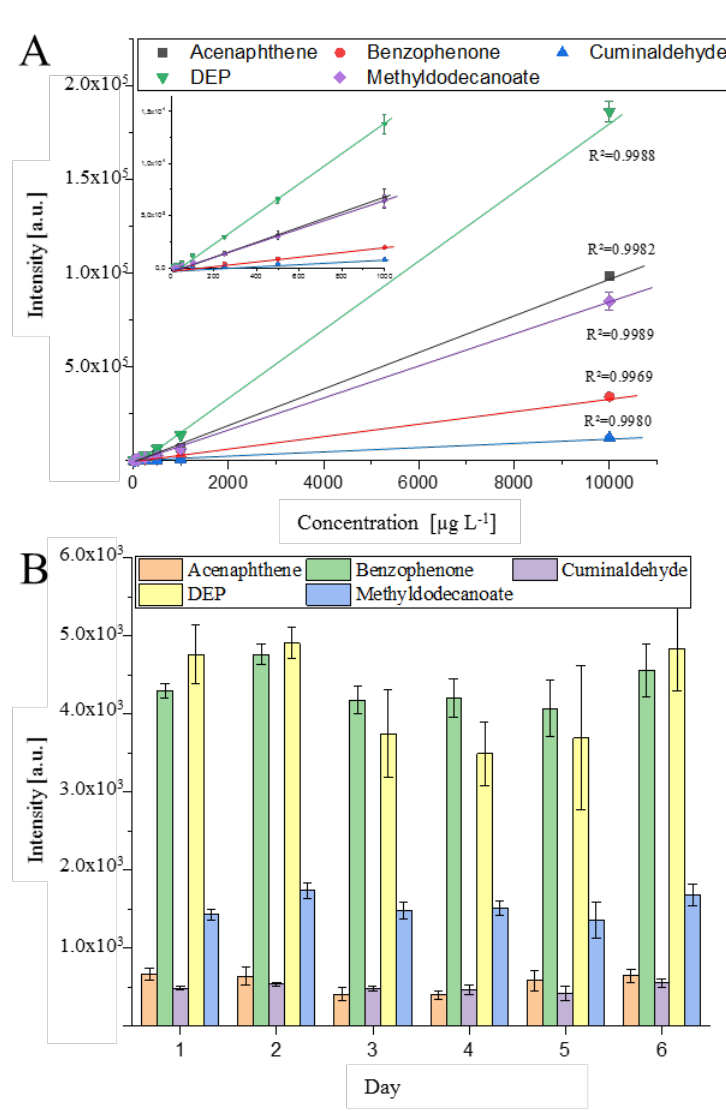
Figure 4. Performance of the prototype ion source. ( A ) shows the linearity and standard derivation of the standards between 10–10,000 µ g L − 1 . Each concentration was analyzed three times ( n = 3). ( B ) shows the repeatability of the measured values over six days with five injections ( n = 5) at 1 mg L − 1 each day.